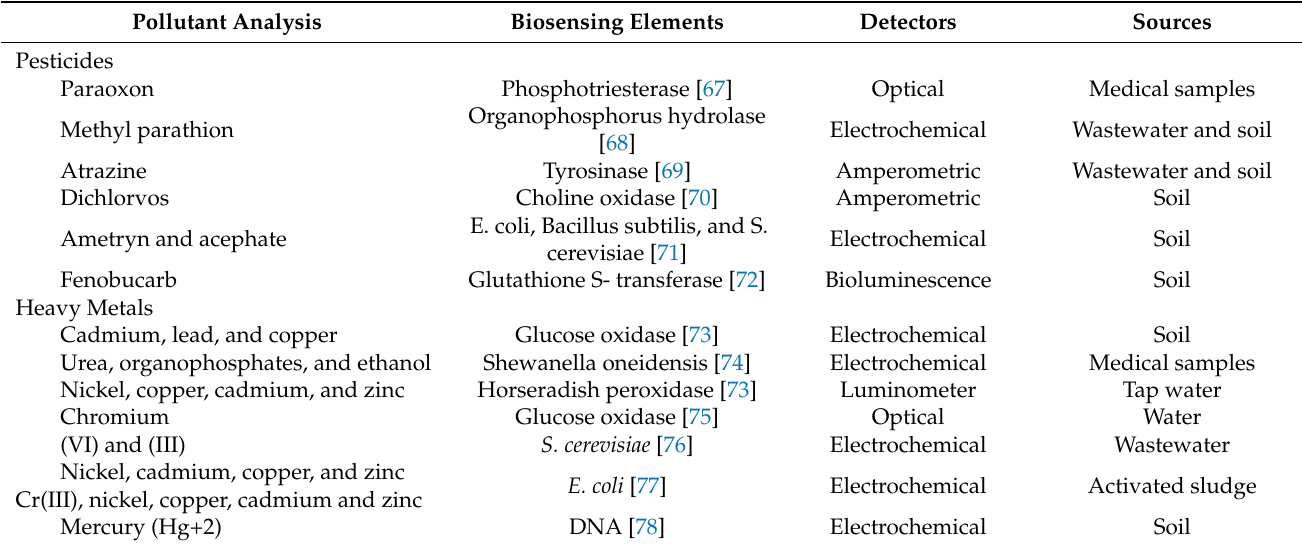
Table 3. Important biosensors developed for the detection of certain toxic